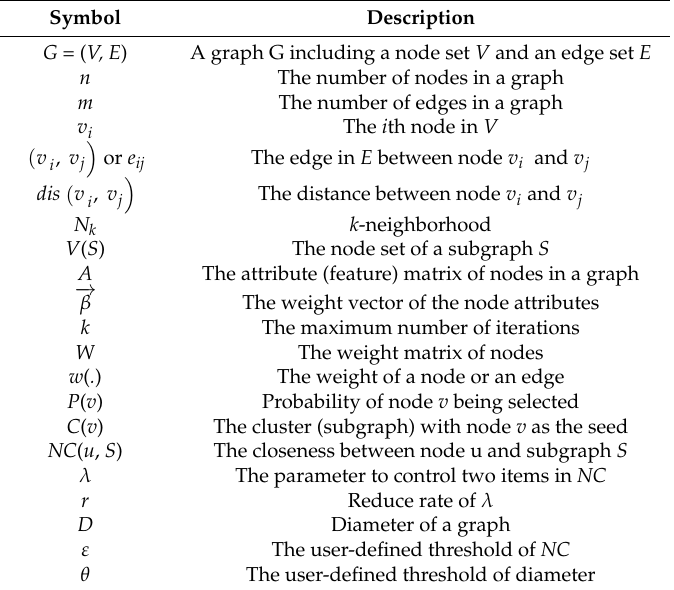
Table 1. Description of the main symbols used in this